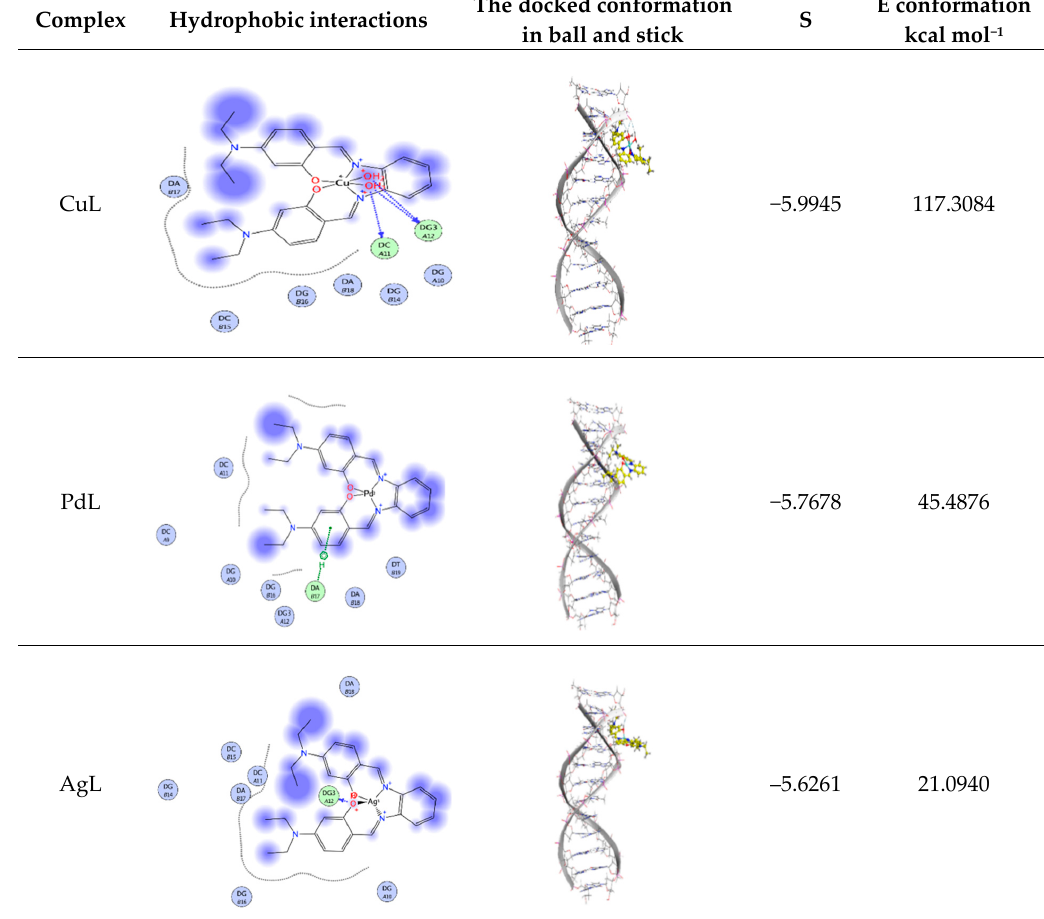
Figure 9. Hydrophobic interaction and docked conformation in ball and stick representation of the interaction of CuL, PdL and AgL complexes with CT-DNA.